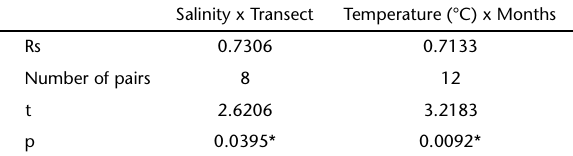
Table II. Spearman's Rank test for salinity vs. number of individuals per transect and temperature ( ° C) vs. number of individuals per month. *p <